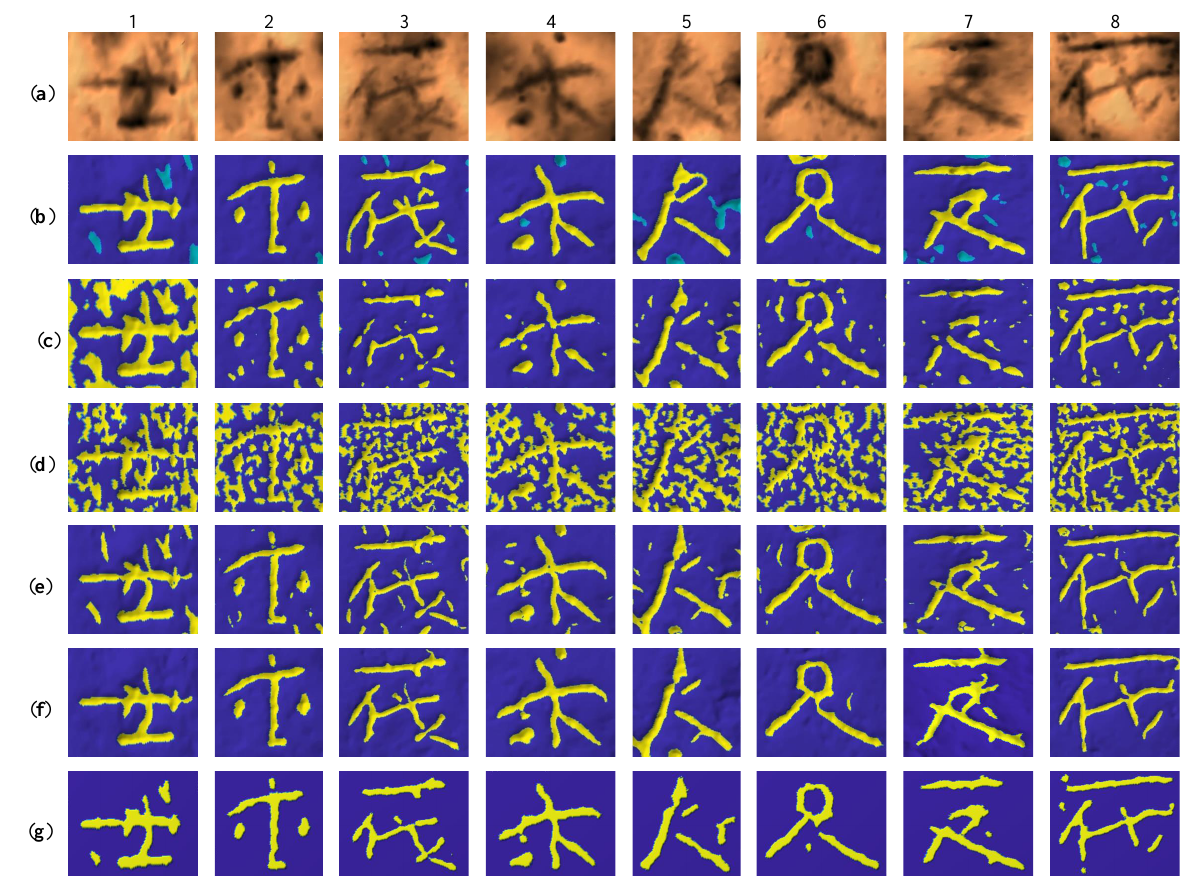
Figure 13. The comparison of the proposed method and existing methods: ( a ) mesh partitions; ( b ) ground truth; ( c ) the height-based method [8]; ( d ) the curvature-based method [7]; ( e ) the modified curvature-based method [18]; and ( f ) the SVM-based method [24]. ( g ) The proposed